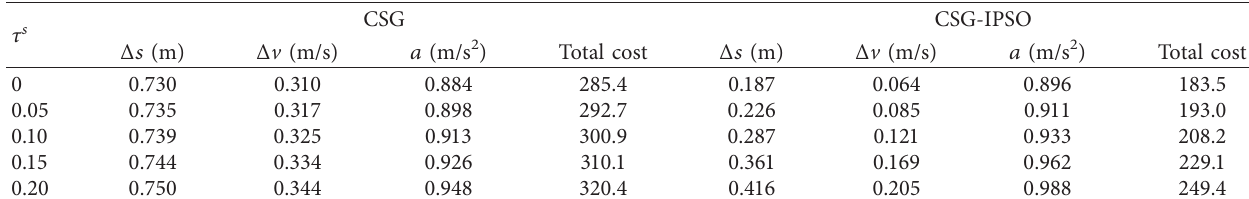
Table 4: Sensitivity analysis of communication lag of CSG and CSG-IPSO.